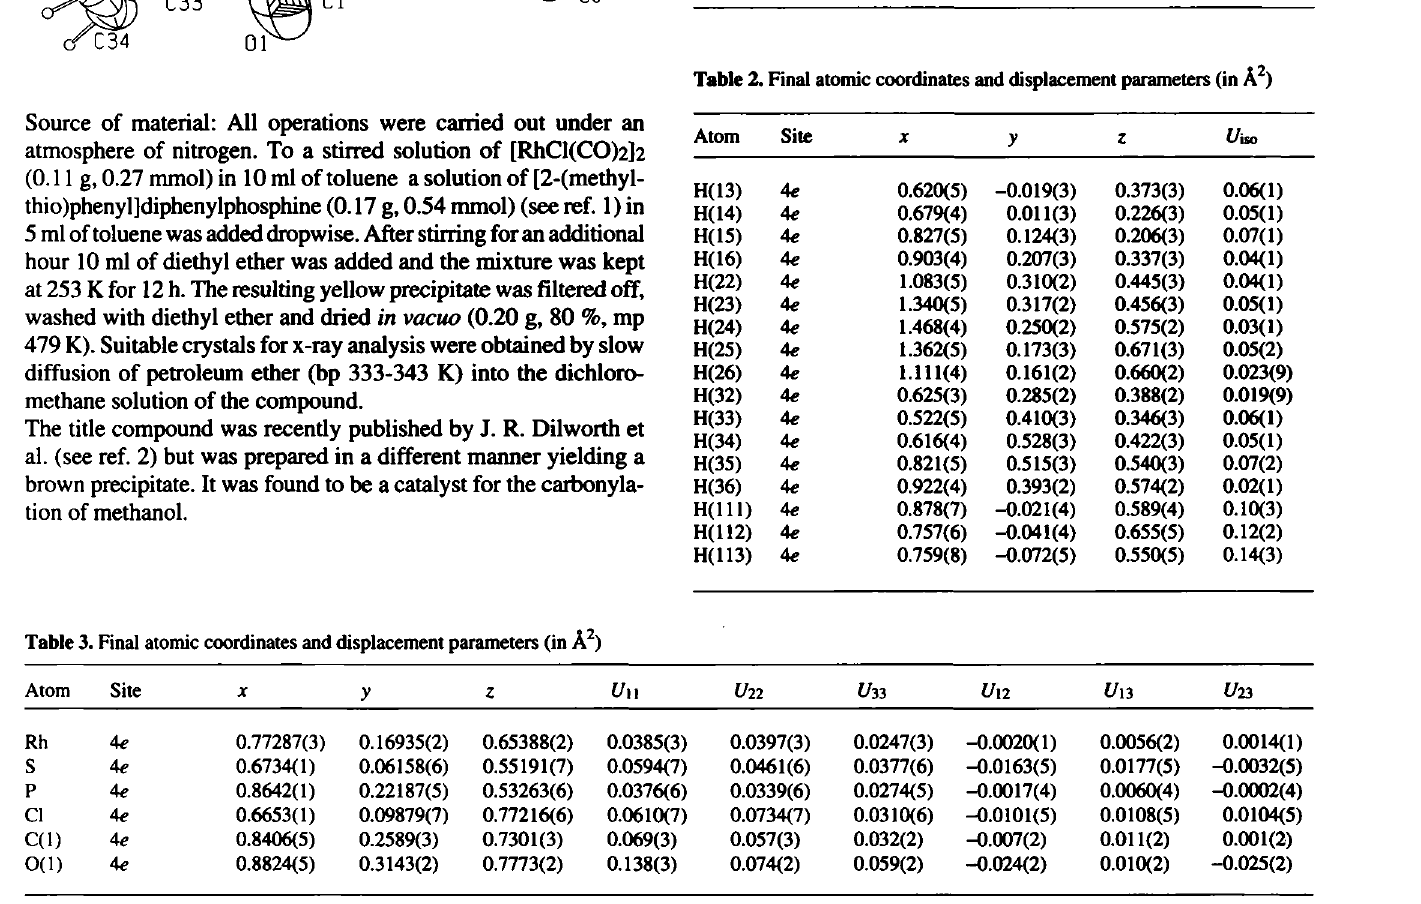
Table 3. Final atomic coordinates and displacement parameters (in Â 2